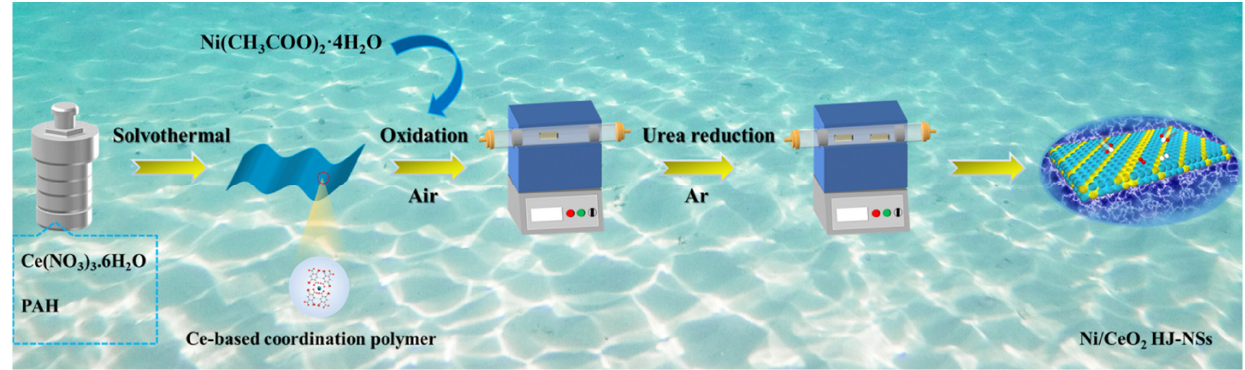
Figure 1. Schematic representation of the synthesis process of Ni/CeO 2 HJ ‐ NSs.